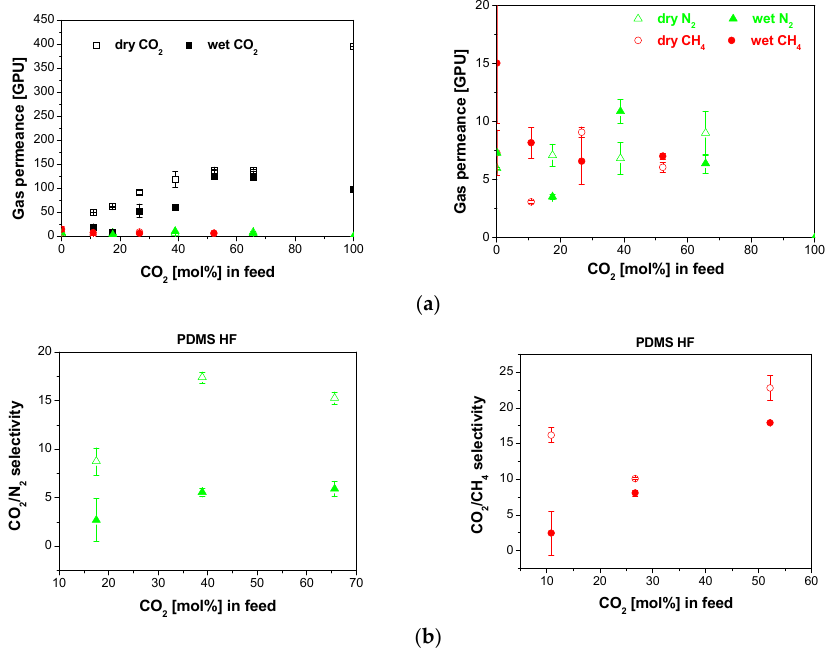
Figure 3. Gas permeance ( a ) and selectivity ( b ) obtained for the separation of CO 2 /N 2 (left) and CO 2 /CH 4 (right) mixtures through the commercial PDMSXA ‐ 10 HF membrane in dry (void symbols) and wet (full symbols). The right side of figure ( a ) shows the trend in the slow gas (N 2 , CH 4 ) permeance.